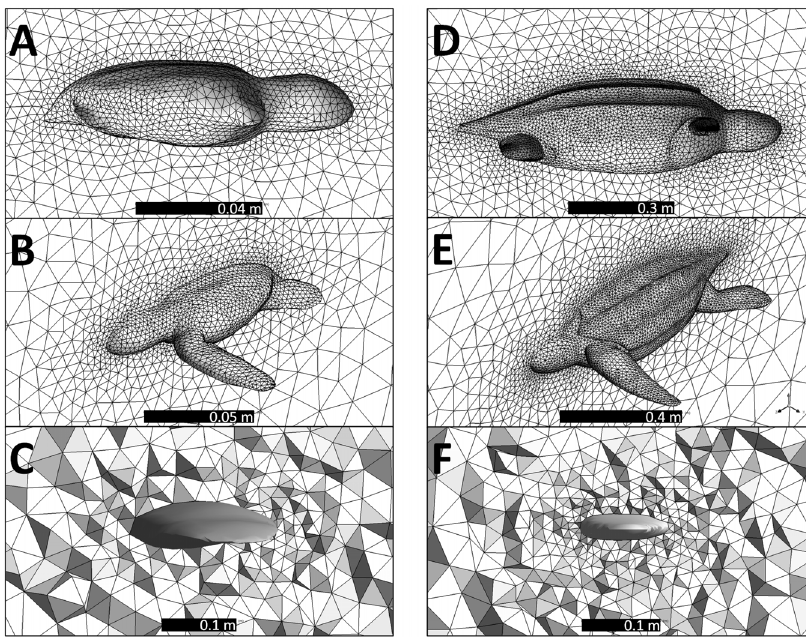
Figure 3. The mesh around the neonate model. Seen (A) from outside looking at the symmetry plane and (B) from inside the fluid volume looking towards the symmetry plane. (C) The mesh on a plane bisecting the neonate flipper at its midpoint. The mesh around the juvenile model seen (D) from outside looking at the symmetry plane and (E) from inside the fluid volume looking towards the symmetry plane. (F) The mesh on a plane bisecting the juvenile flipper at its midpoint.